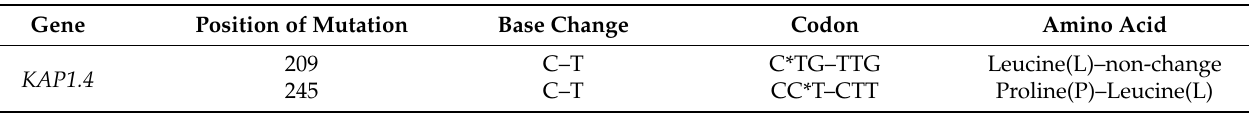
Table 3. Genotype and allele frequencies of gene KAP 1.4 of the cashmere goat at the 245 bp